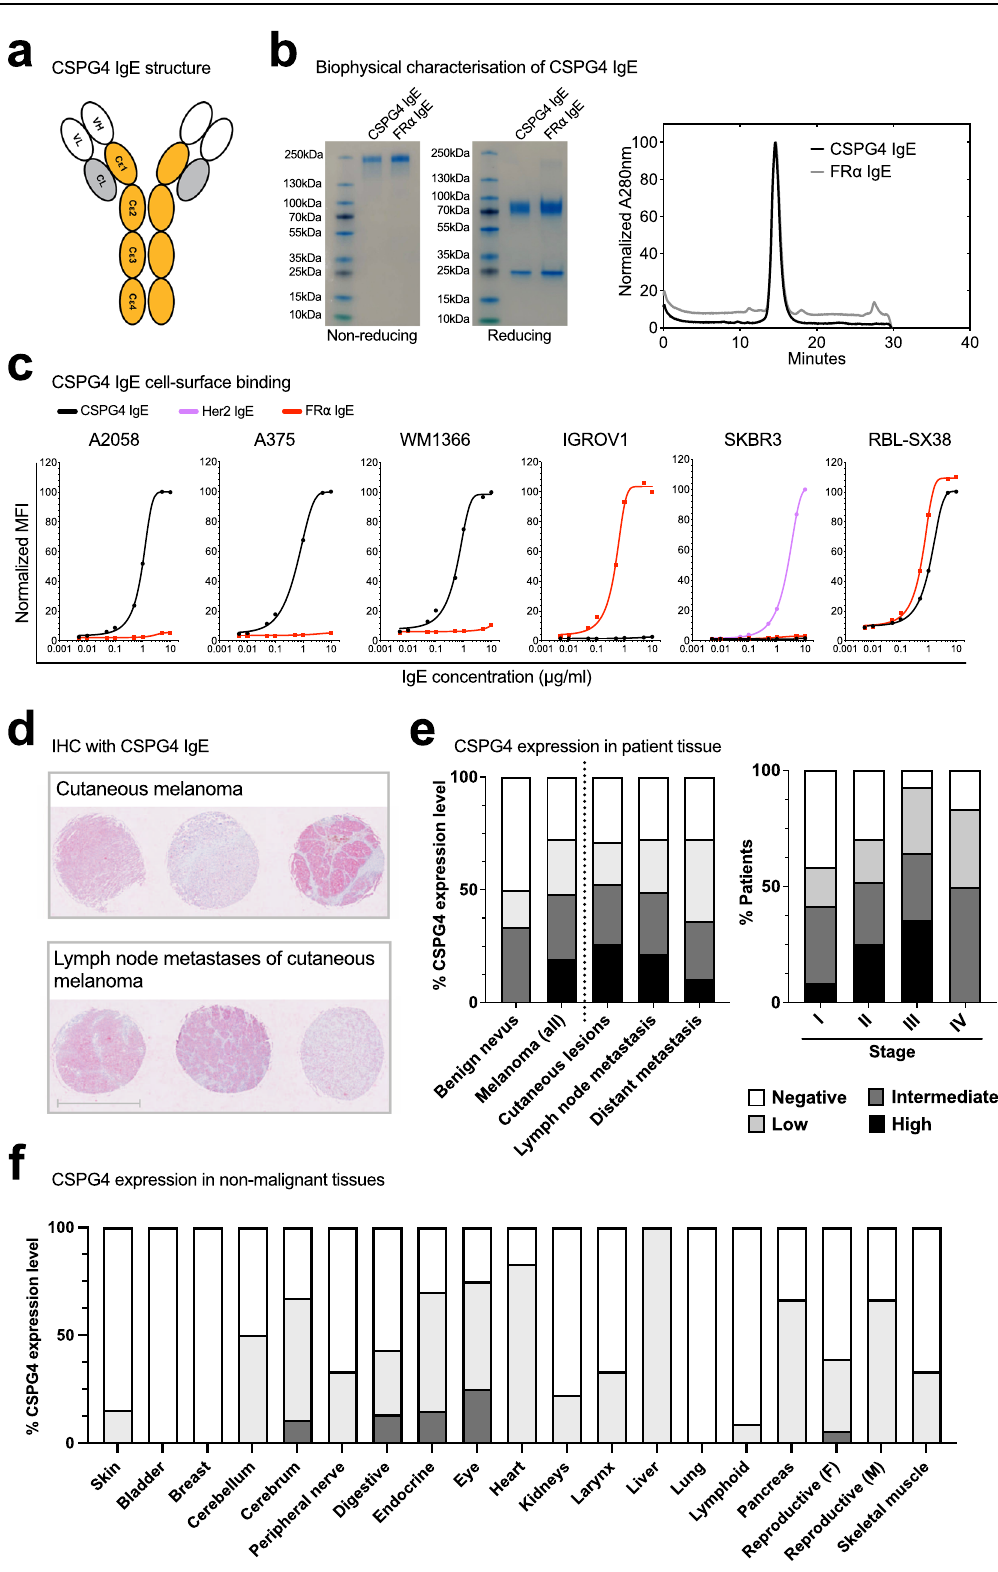
of CSPG4 to unoccupied Fc ɛ receptor I (Fc ɛ RI) on primary human monocytes was con fi rmed by fl ow cytometry (Fig. 3f, left). CSPG4 IgE- mediated ADCC of A375 and A2058 melanoma cells was triggered by monocytes derived from both healthy participants (Fig. 3f, right) and patients with melanoma (Fig. 3g). Contrastingly, CSPG4 IgE-engaged effector cells did not trigger ADCC of intermediate